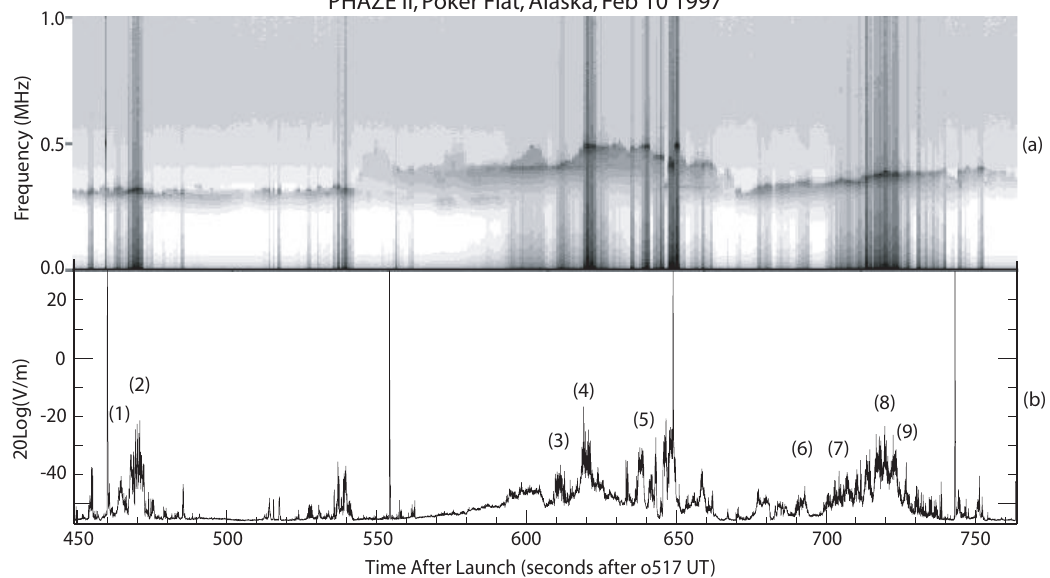
Fig. 1. (a) Sequence of Fast Fourier Transform (FFT) spectra of the measured HF electric field with frequency resolution of 9.76 kHz. There is a 70 dB difference between white and black on the grayscale. The horizontal axis is time since launch in seconds, and the vertical axis is frequency in MHz. Vertical bands, such as at 640 s or 670 s, arise from the action of the AGC as discussed in the text. (b) The logarithm of the absolute value of the amplitude of the electric field for the same 449-763 s time period. The data are expressed in decibel units (20log 10 (V/m)). These data represent 6 ms averages and only one out of four points is displayed. The AGC has been accounted for in both panels; calibration signals are removed from the top panel.